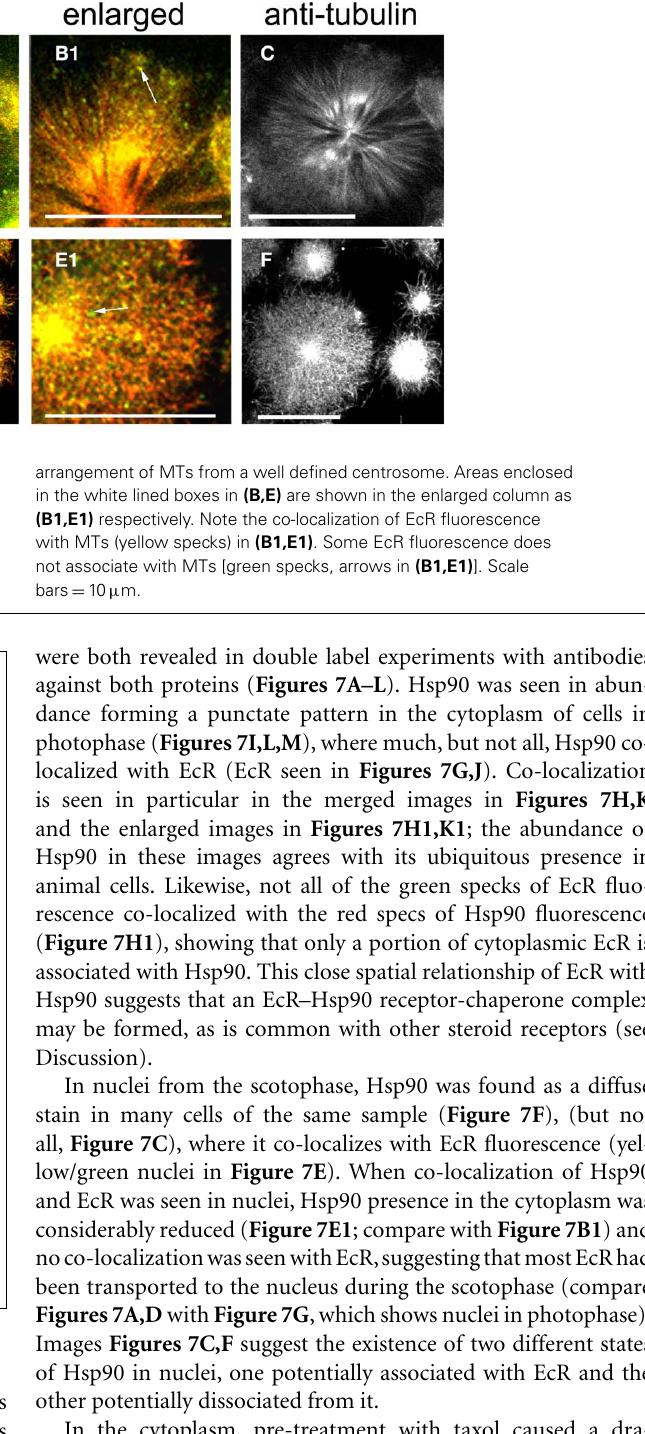
CO-LOCALIZATION OF EcR WITH THE MOLECULAR CHAPERONE Hsp90 Co-localization of EcR with the molecular chaperone Hsp90 was examinedinSGcells. Rhodnius SGsconsistof asinglelobewhichis composed of an epithelial monolayer of flat binucleate cells (about 6–8 μ m thick) surrounding the lumen that contains the salivary secretions. These cells are very large (about 40 μ m in diameter) which makes them ideal for cytological analysis of their cytoplas- mic constituents. The cellular distribution of Hsp90 ( Figure 7 right, red) and its co-localization with EcR ( Figure 7 left,